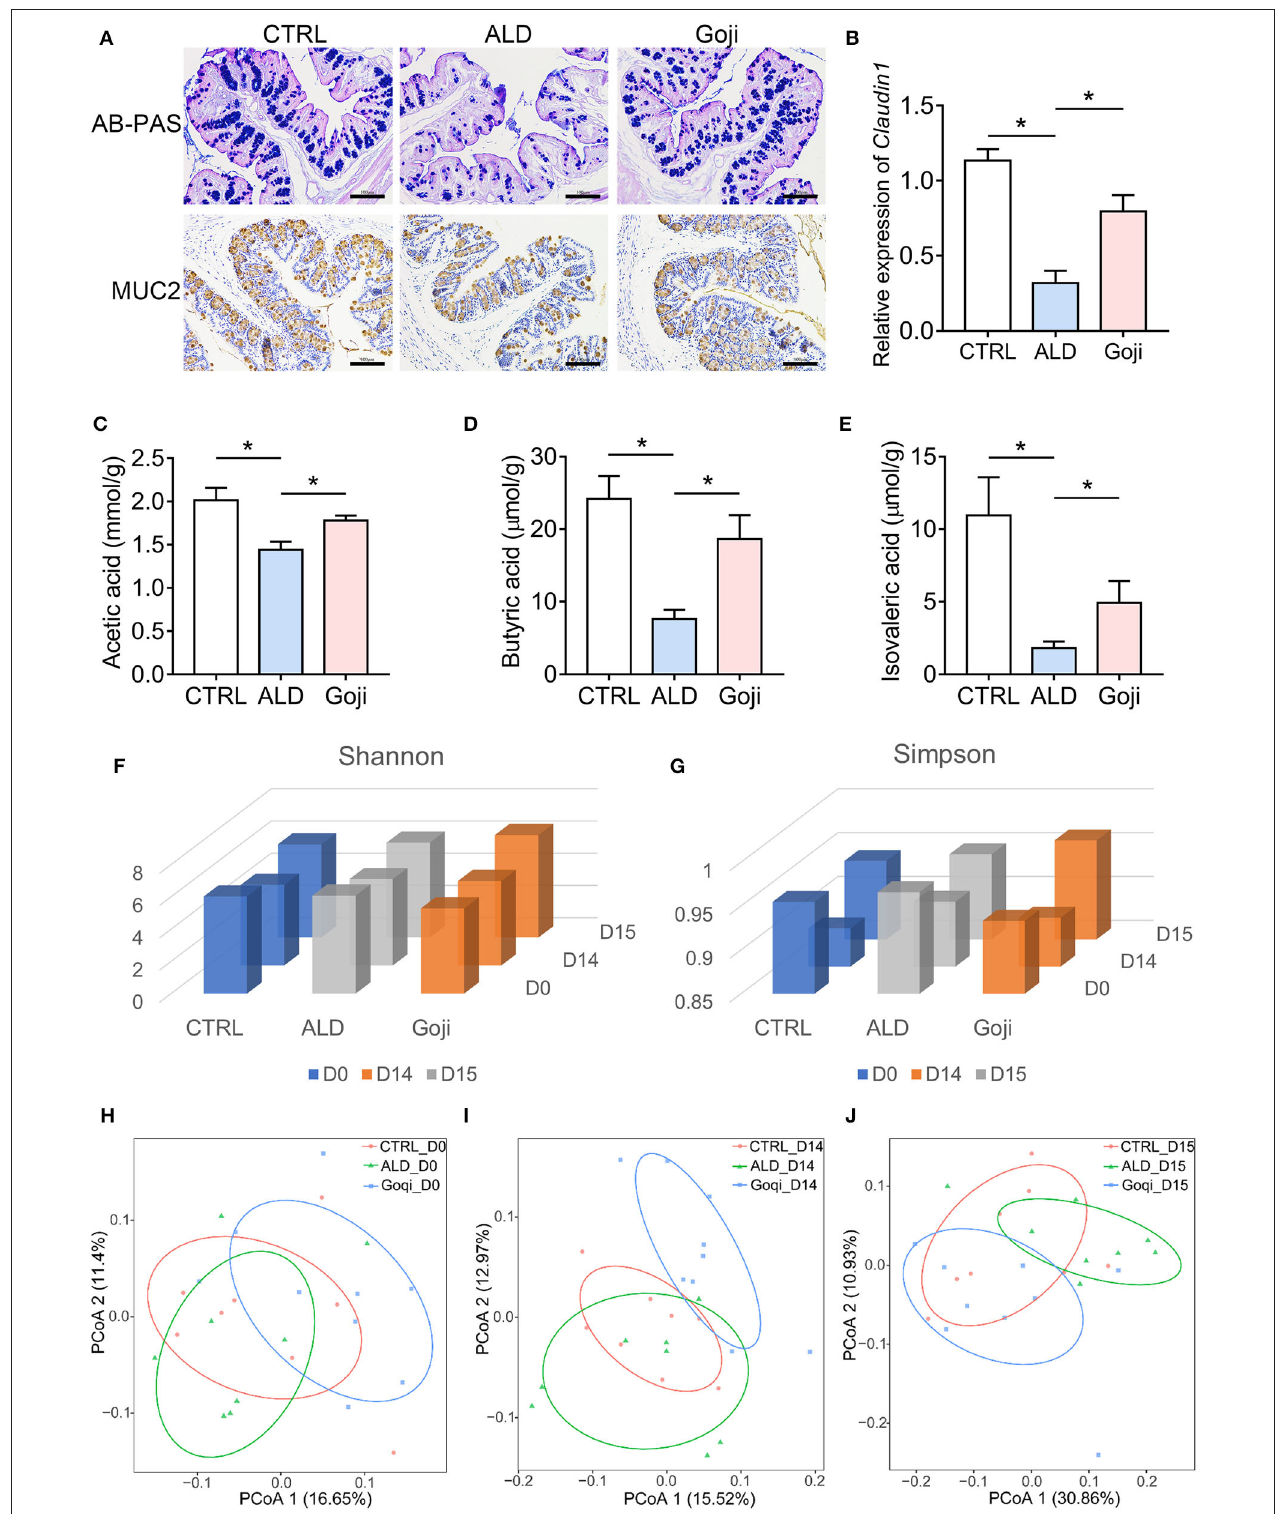
FIGURE 2 | Goji maintained the gut microenvironment and modulated the overall structure of gut microbiota. (A) AB–PAS staining and immunohistochemical analysis of the expression of MUC2 of colon section. Scale bars, 100 µ m. (B) The relative expression of Claudin1 in the colon. (C) quantification of cecal acetic acid. (D) quantification of butyric acid. (E) quantification of isovaleric acid. (F) Shannon index of microbiota; (G) Simpson index of microbiota. (H) principal-coordinate analysis (PCoA) plot at D0 based on unweighted UniFrac distance. Each point represents each sample. (I) PCoA plot at D14. (J) PCoA plot at D15. F–J, n = 8. Data are shown as mean ± SEM, and statistical significance is assessed by one-way ANOVA corrected for multiple comparison by Tukey’s test. * p -value < 0.05.